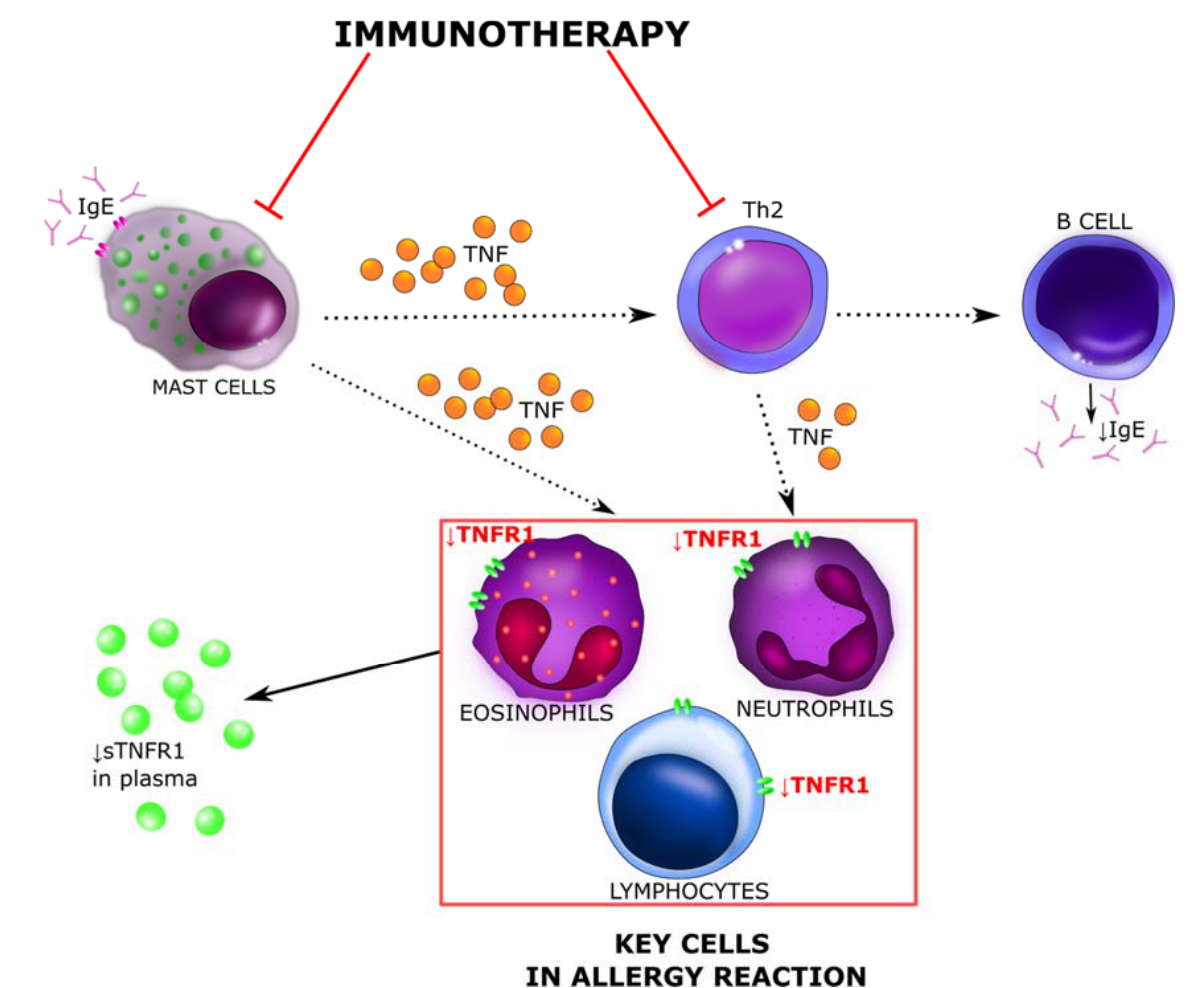
Figure 8. The molecular mechanism determining sTNFR-1 serum levels. Red arrows indicate blocking activity induced during venom allergen immunotherapy. Mast cells play an important role both in IgE-dependent and IgE-independent allergy responses. They have the ability to synthesize and secrete many different cytokines, including IL-3, IL-4, IL-5, and TNF alpha which can extend the allergic reaction. The cytokines and other mediators secreted by mast cells cause an influx of T cells, monocytes and eosinophils into the site of the sting, causing a late-phase reaction (after 6–12 h) dominated by a cellular infiltrate. TNF alpha is a cytokine that plays an important role in allergic reaction. In allergic diseases, elevated levels of TNF reportedly trigger an inflammatory cascade through TNFR1. Immunotherapy causes a decrease in the level and activity of mast cells and Th2 lymphocytes. Both of them secrete TNF, which the major receptor is TNFR1, and is found on most cells of human body. The decrease in TNF production causes a reduction of TNFR1 receptors on the cell membrane and lowers sTNFR1concentration in serum [30,31]. sTNFR-1—soluble tumor necrosis factor receptor 1; Th2—T helper 2 cells.